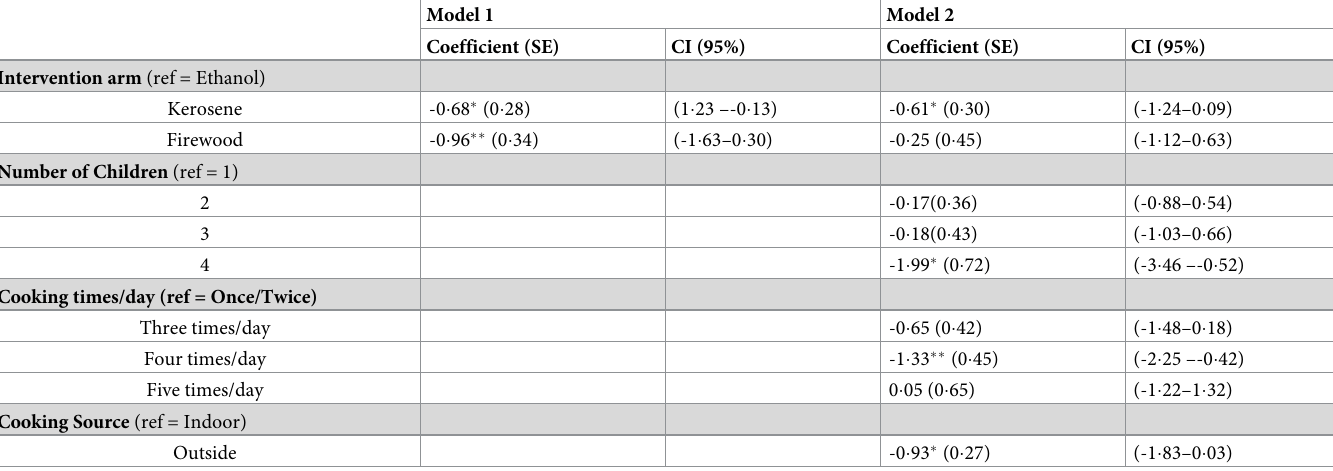
Table 5. Univariate and multivariate analysis of association between intervention arm and